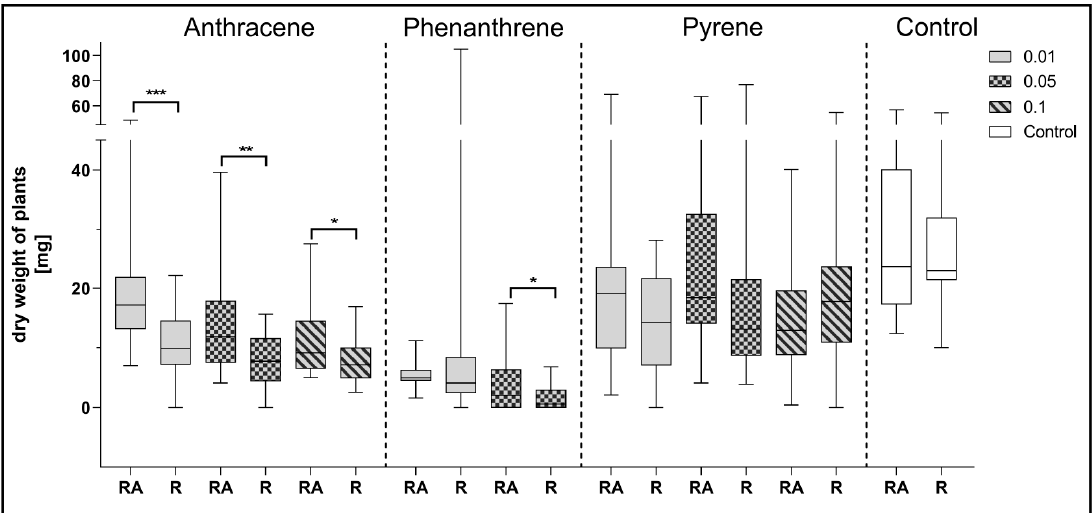
Figure 5. Comparison of the effect of inoculation of clover with only R. leguminosarum strains and with co-inoculation with A. brasilense on dry weight of clover (mg). The dotted posts indicate the co- inoculation with A. brasilense variant. The results are presented as a boxplot with median and 2.5–97.5 percentile. The symbols indicate significant results at: * p ≤ 0.05; ** p ≤ 0.01; *** p ≤ 0.001; α = 0.05. Figure presents only those strains for which statistically significant differences were noted.